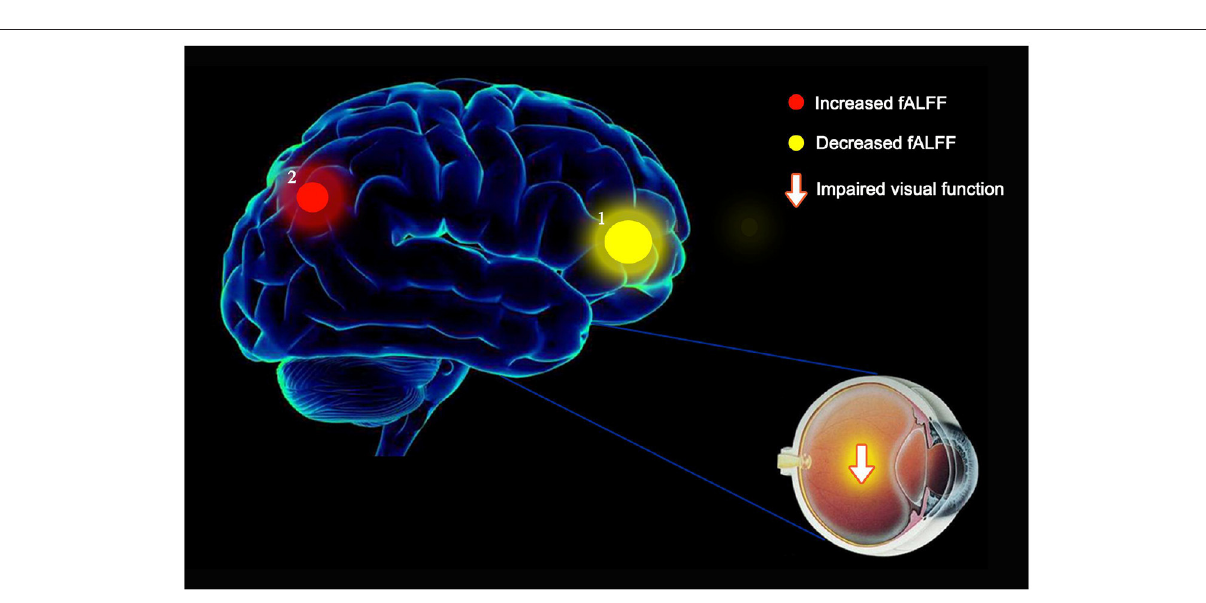
FIGURE 5 | The mean fALFF values of altered brain regions in the OH group. (1) Compared with the HC, the fALFF values of the following regions were decreased to various extents: LAC (BA1, t = 5.5535). (2) Compared with the HC, the fALFF values of the following regions were increased to various extents: LP (BA2, t = − 3.7520). fALFF, fractional amplitude of low-frequency fluctuations; ALFF, amplitude of low-frequency fluctuations; OH, ocular hypertension; HC, healthy control; R, right; L, left; BA, Brodmann’s area; LAC, left anterior cingulate; LP, left